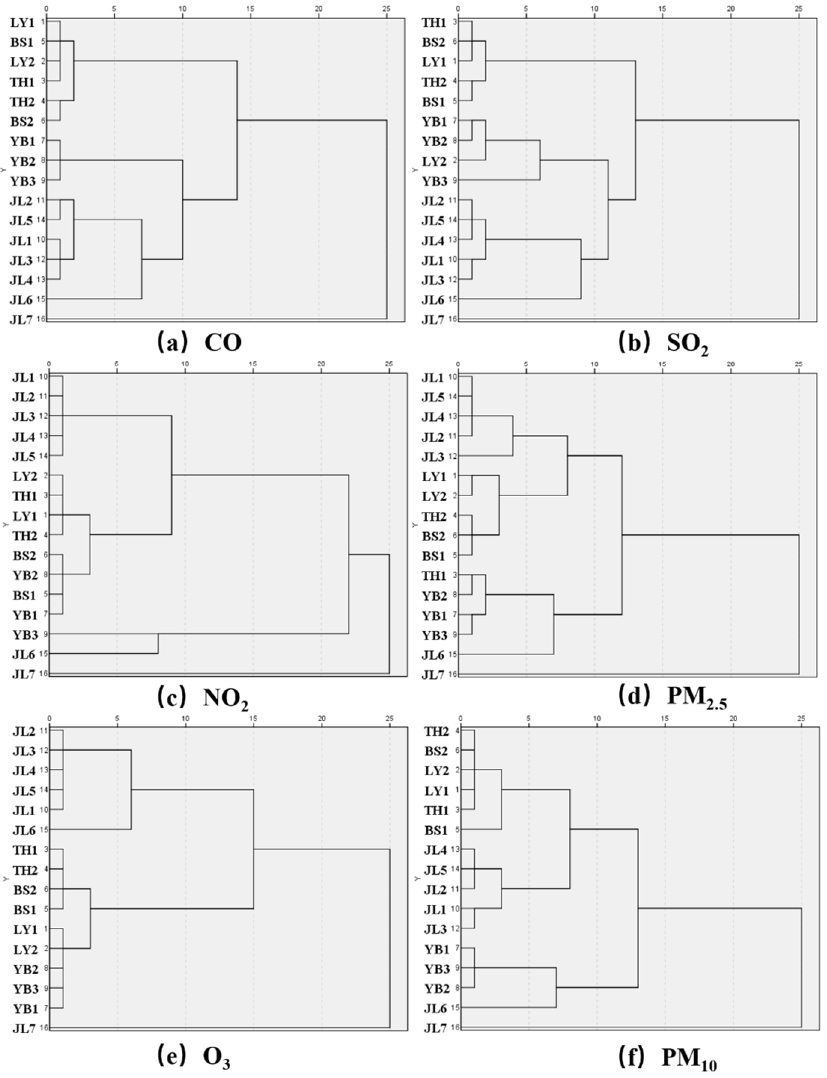
Figure 4. Cluster analysis of 16 monitoring stations based on pollutant concentration. ( a ) CO; ( b ) SO 2 ; ( c ) NO 2 ; ( d ) PM 2.5 ; ( e ) O 3 ; ( f ) PM 10 .